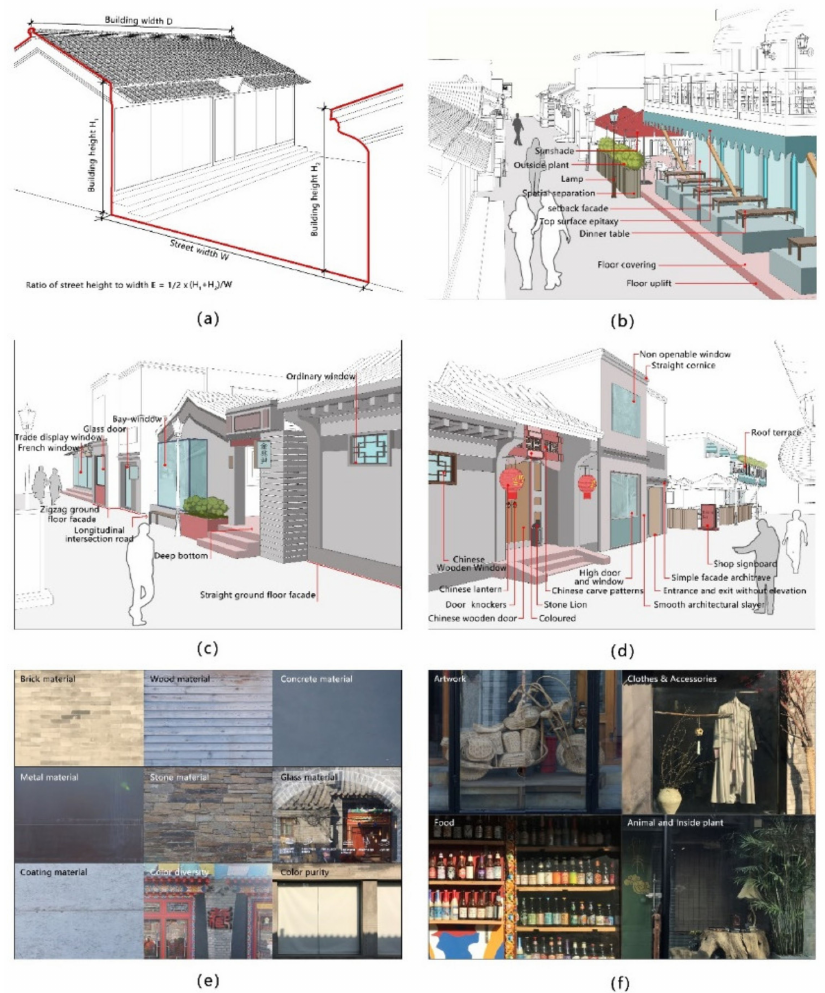
Figure 2. Diagram and images of six groups of micro-scale built environment features of historic streets: ( a ) scale of streets and buildings; ( b ) street transitional spaces; ( c ) ground floor features along the street; ( d ) building façade features; ( e ) building colors and materials; ( f ) contents of merchandise